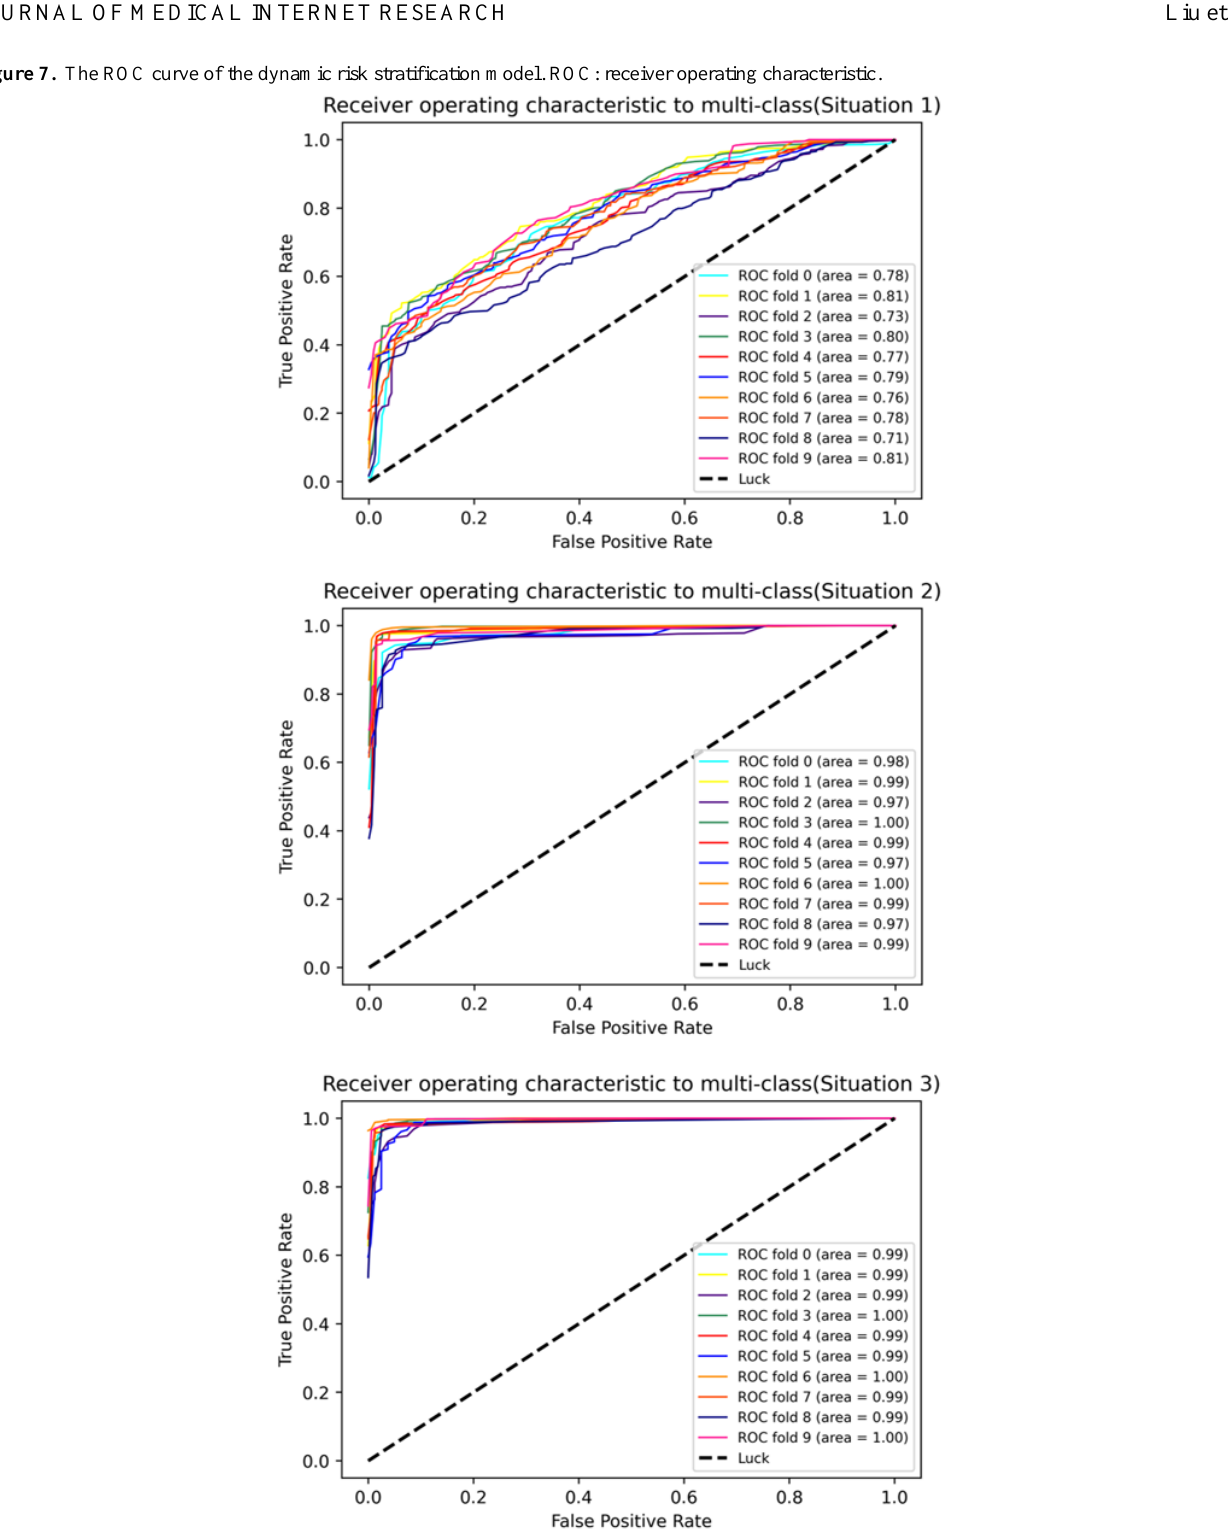
Table 2. All indicators were averaged after 10-fold cross-validation, and Class 1, Class 2, and Class 3 refer to low risk, moderate risk, and high risk,